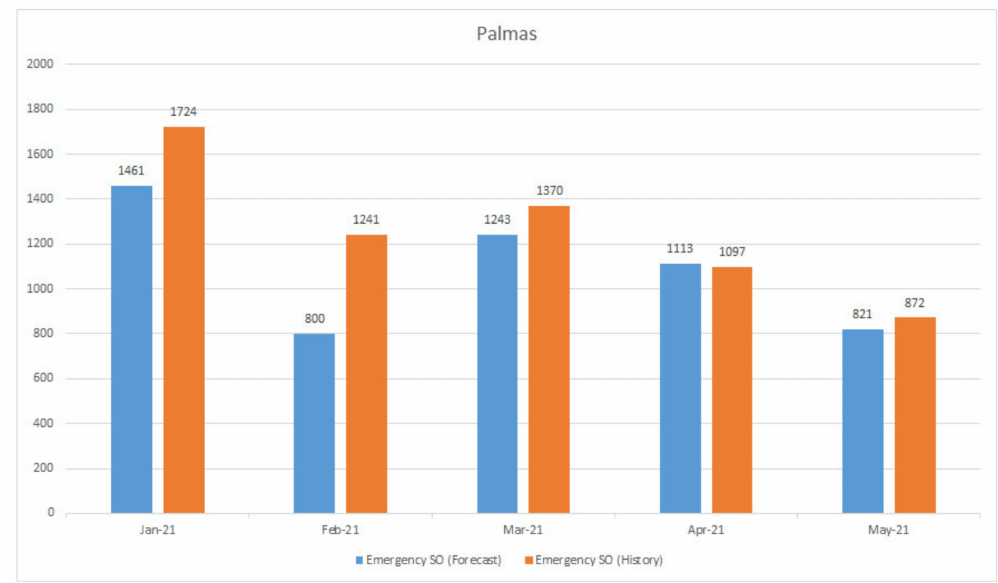
Figure 11. Forecasted ( blue ) versus history ( orange ) emergency service orders for Palmas city in